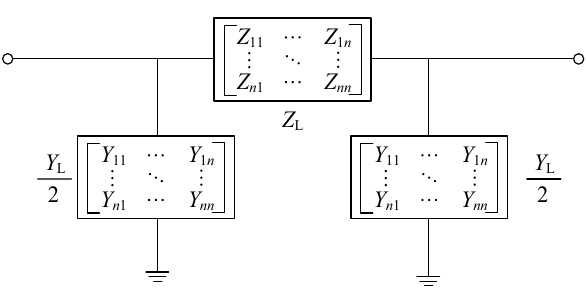
Fig. 7 The π type equivalent circuit of traction network